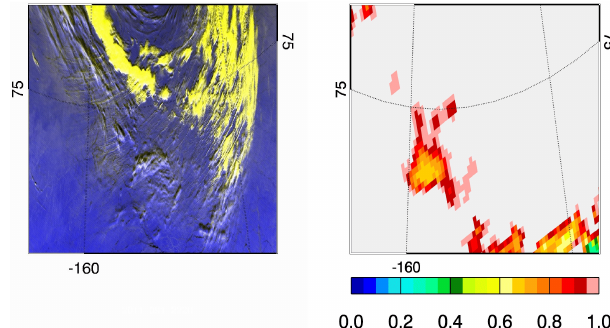
Figure 6. (Left) MODIS false colour image for 1 April 2011 at 22:20UTC and (right) SMOS satellite retrievals of sea ice thickness [m] for 1 April 2011. Both panels show a subarea of the MODIS image given in the middle panel of Fig. 3e. In the MODIS image, snow and ice on the ground should appear blue, while clouds and suspended snow particles should appear yellow (see